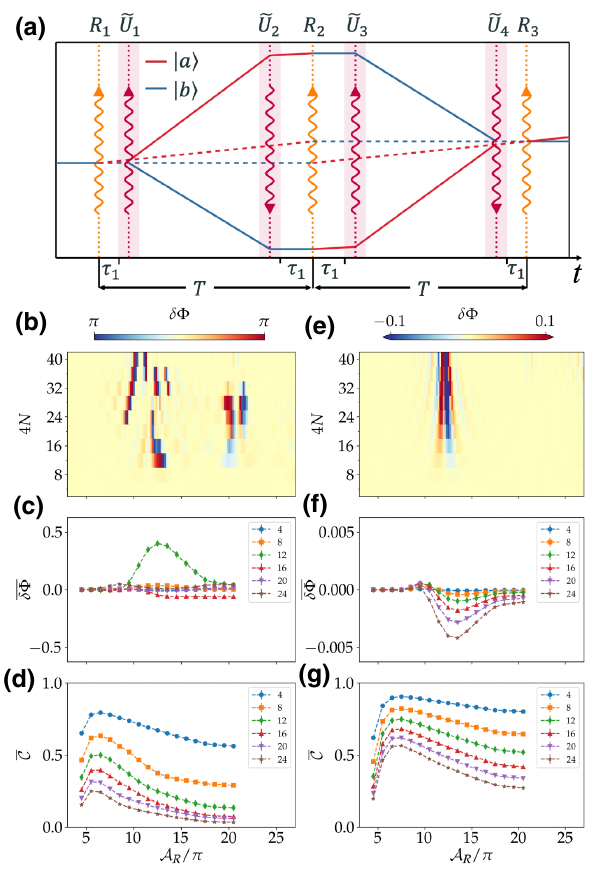
FIG. 9. Enhancing the enclosed area of an atom interfer- ometer with four ˜ U uddu ( ± k R ) SDK sequences. (a) Schematic of the interferometry scheme. The dashed lines at t = 0, T , 2 T represent regular Raman interferometry controls for the R 1 = R ϕ (π/ 2 ) splitter, R 2 = R ϕ (π) mirror and R 3 = R ϕ (π/ 2 ) com- biner of the spinor matterwave, respectively, with ϕ = k R · r . The atomic wave functions in | b (cid:4) and | a (cid:4) states are represented by the blue and red lines [3]. The four thick vertical lines at t = τ 1 , T − τ 1 , T + τ 1 , 2 T − τ 1 with red curved arrows repre- ( k ) , ˜ U = ˜ U ( 4 N ) ( − k ) , ˜ U = ˜ U ( 4 N ) ( − k ) , and sent ˜ U 1 = ˜ U ( 4 N ) 2 3 R R R uddu uddu uddu ˜ U = ˜ U ( 4 N ) ( k ) sequences, respectively. We consider τ (cid:18) T . 4 1 R uddu By properly choosing the τ 1 / T ratio, spurious interference by multiple imperfect controls can be suppressed, and are not included in the simulations. (b)–(d) The interferometry phase off-